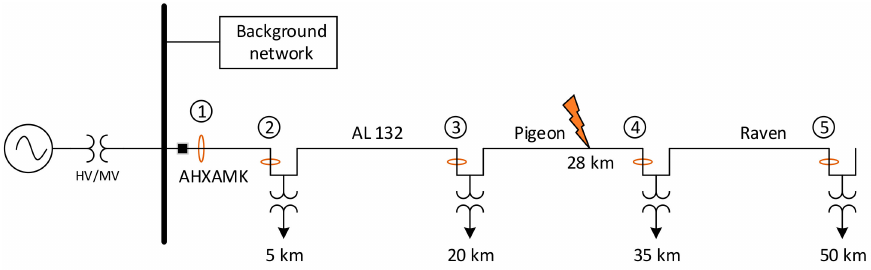
Figure 16. Rural isolated